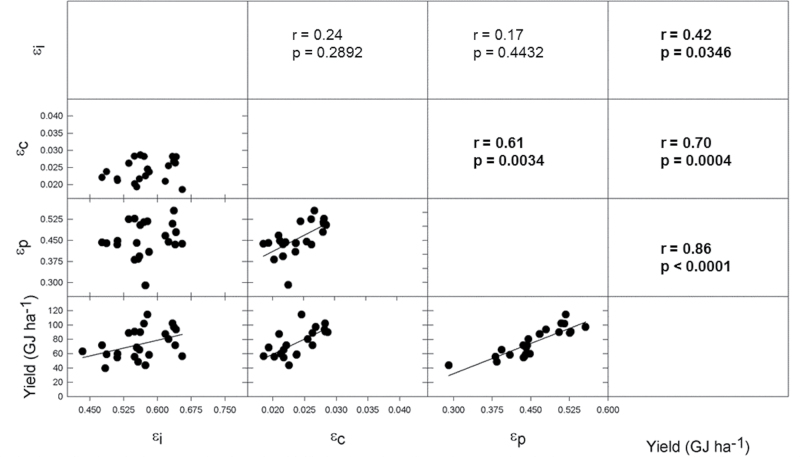
2012 correlation matrix of yield and Monteith efficiencies. εp is expressed in terms of biomass (g seed/g total aboveground biomass). Scatterplots and correlation coefficients are plotted in a matrix where lines represent significant least-squares regression. Bold indicates significant results.